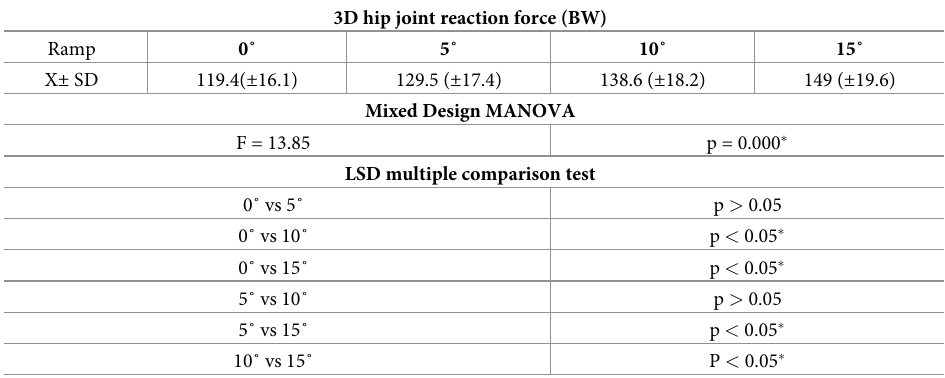
Table 1. Descriptive statistics and Mixed Design MANOVA for 3D hip JRF during single-limb support on the four tested ramps (0˚, 5˚, 10˚, and 15˚) as a multiple of body weight (BW) for all the tested